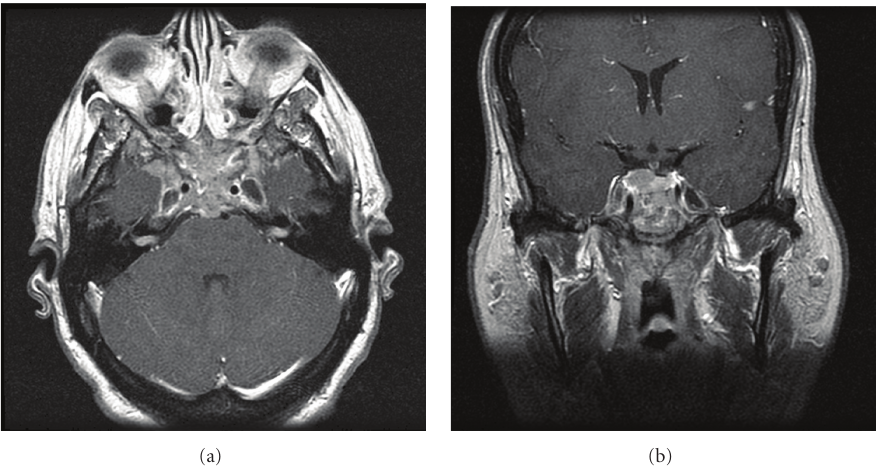
Figure 5: Axial and coronal T1-weighted MR imaging of the brain with gadolinium enhancement demonstrating a heterogeneously enhancing lobulated sellar and suprasellar lesion with extension into the right cavernous sinus and encasement of the right internal carotid